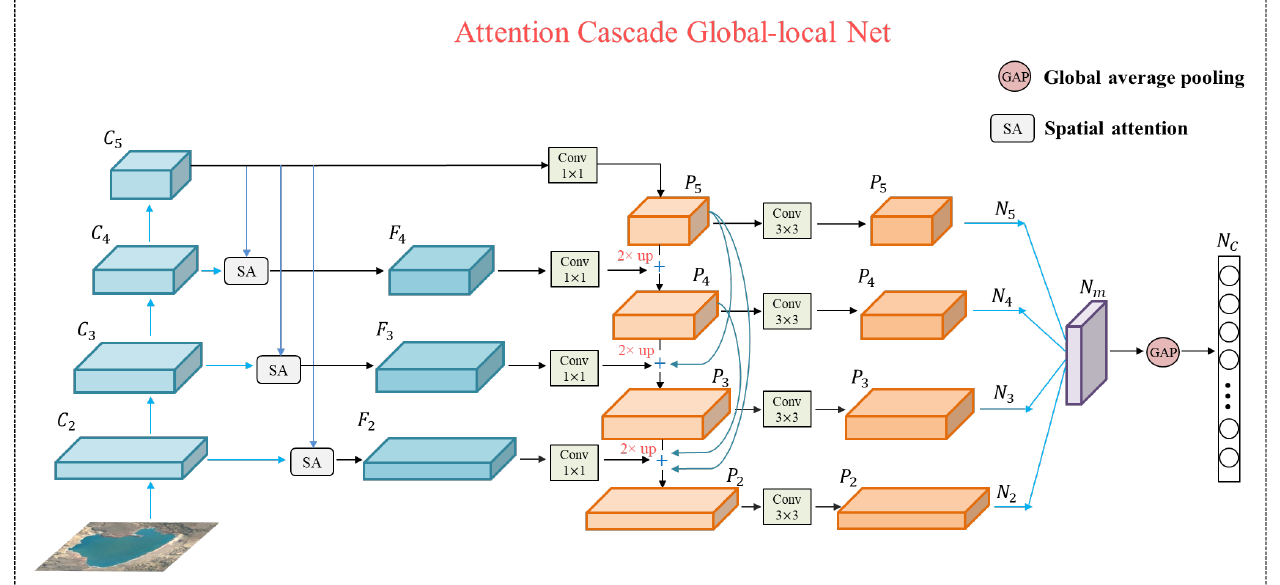
Figure 3. The structure of the proposed